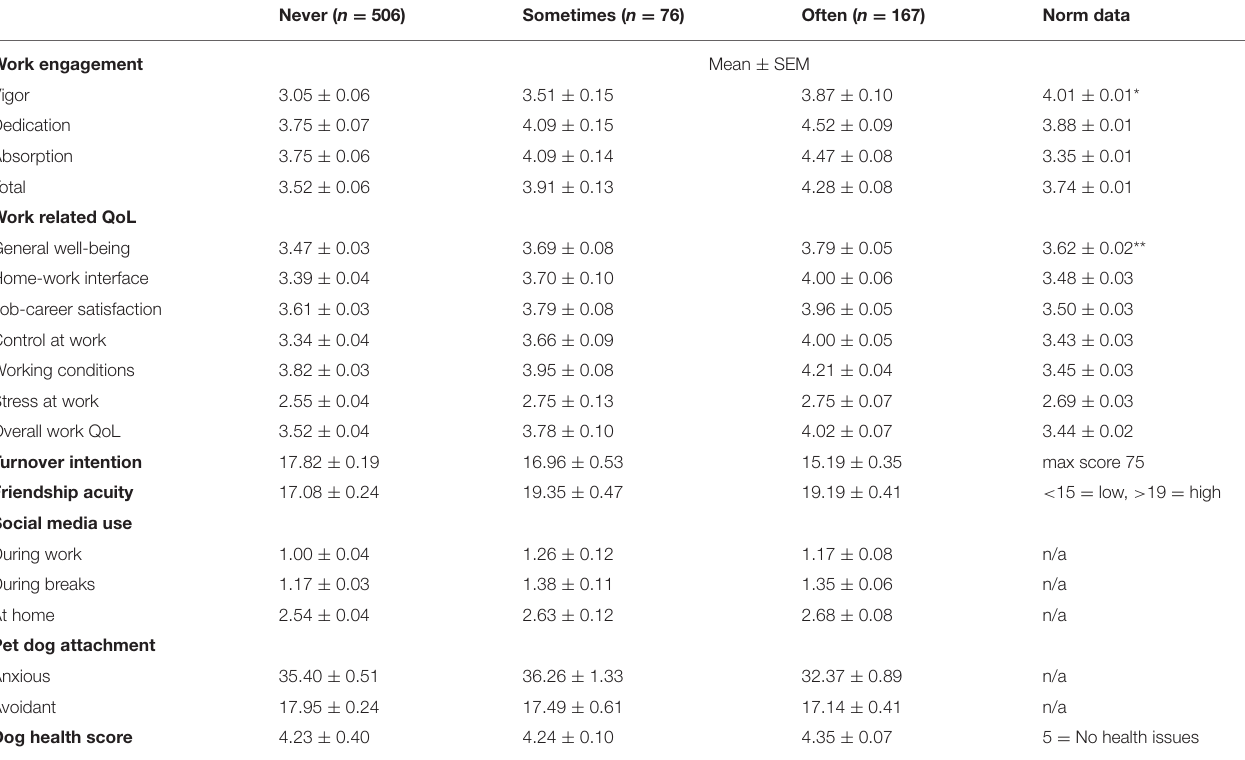
TABLE 2 | Descriptive statistics for work engagement, work-related quality of life (QoL), turnover intention, friendship acuity and social media use, and pet dog attachment, across the three dogs at work groups, including comparison to norm